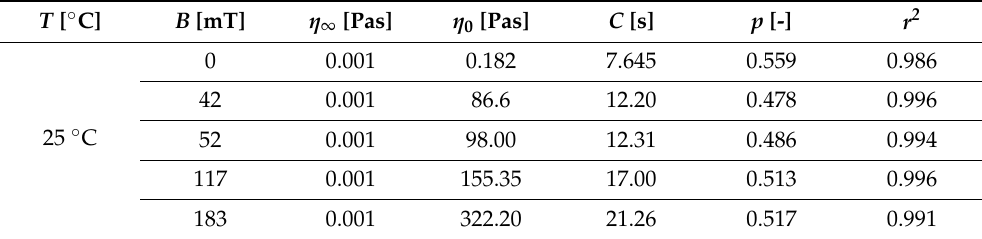
Figure 8. ( A ) The model suspension viscosity curves at T = 25 °C in the presence and absence of the magnetic field are shown; ( B ) MV effect as a function of shear rate at different values of the magnetic flux density, at T =25°C. Table 2. The values of the fit parameters were obtained by fitting the viscosity curves with the Carreau model for different magnetic flux density